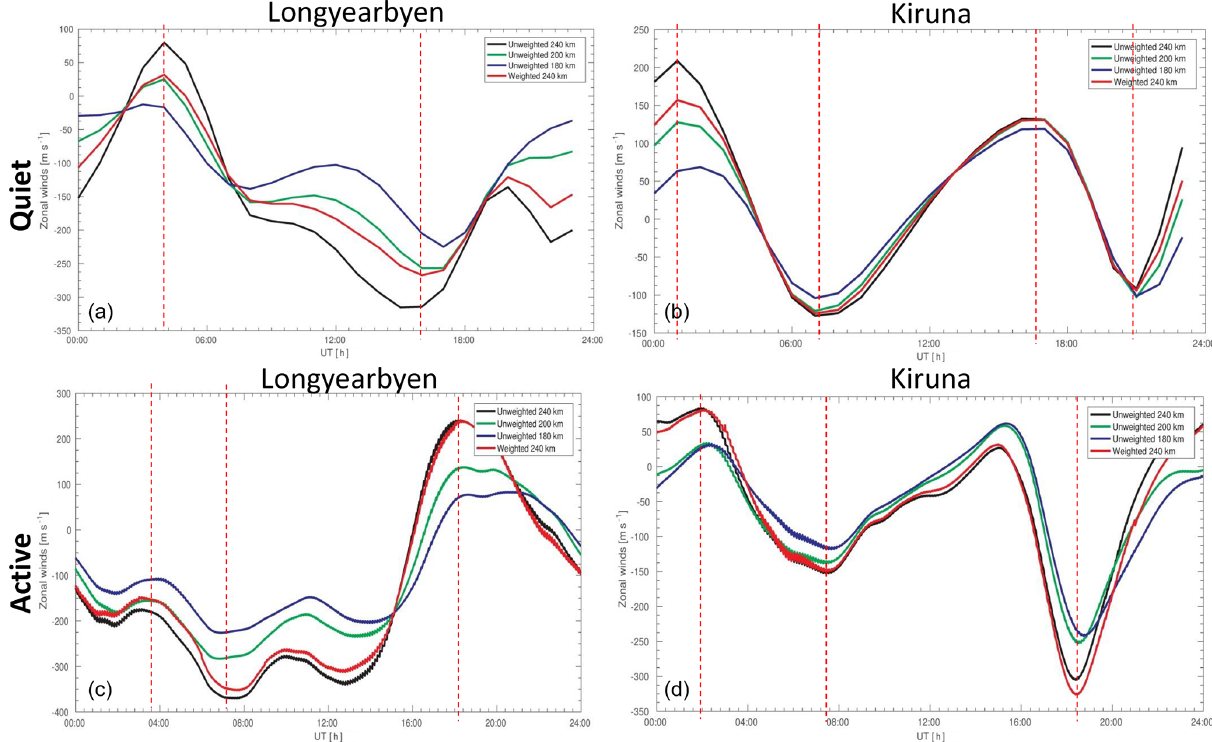
Figure 14. (a, b) CMAT2 zonally averaged zonal winds for a quiet day on 1 December 2007 at Longyearbyen (a, c) and Kiruna (b, d) for winds at 180, 200 and 240km for comparison with the height-integrated winds weighted using an emission intensity profile from the Vlasov et al. (2005) model. (c, d) The same for active conditions on 20 March